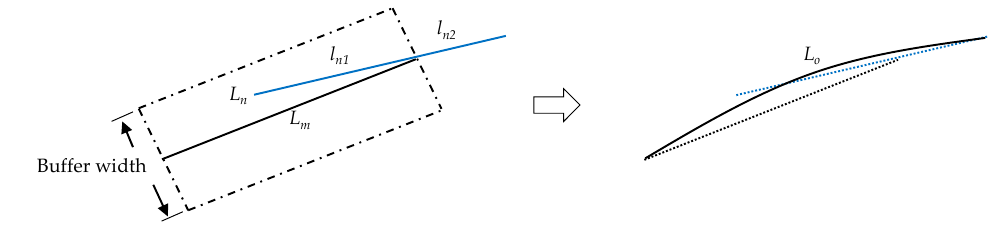
Figure 4. The sketch map of the proposed overlap optimization.